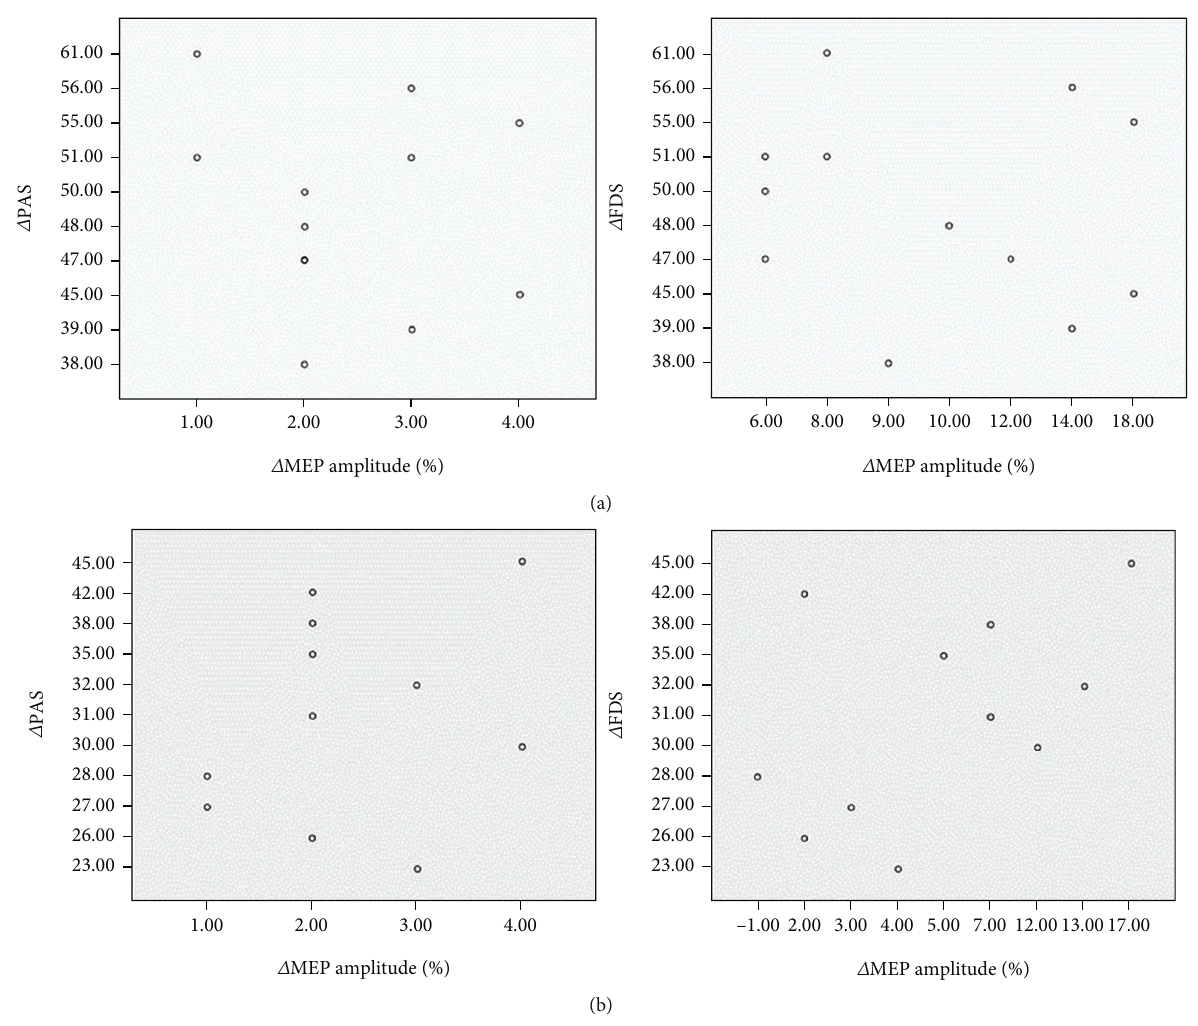
Figure 8: The results of the Pearson correlation analysis showed that there was no correlation between the improvement in patients ’ clinical swallowing function ( Δ PAS : the improvement of PAS after treatment; Δ FDS : the improvement of FDS after treatment) and the increase in MEP amplitude ( Δ MEP amplitude: the improvement of MEP amplitude after treatment) in either the unilateral stimulation group or the bilateral stimulation group. PAS: penetration aspiration scale; FDS: functional dysphagia scale; MEP: motor evoked potential. (a) The scatter plot of bilateral stimulation group; (b) the scatter plot of unilateral stimulation